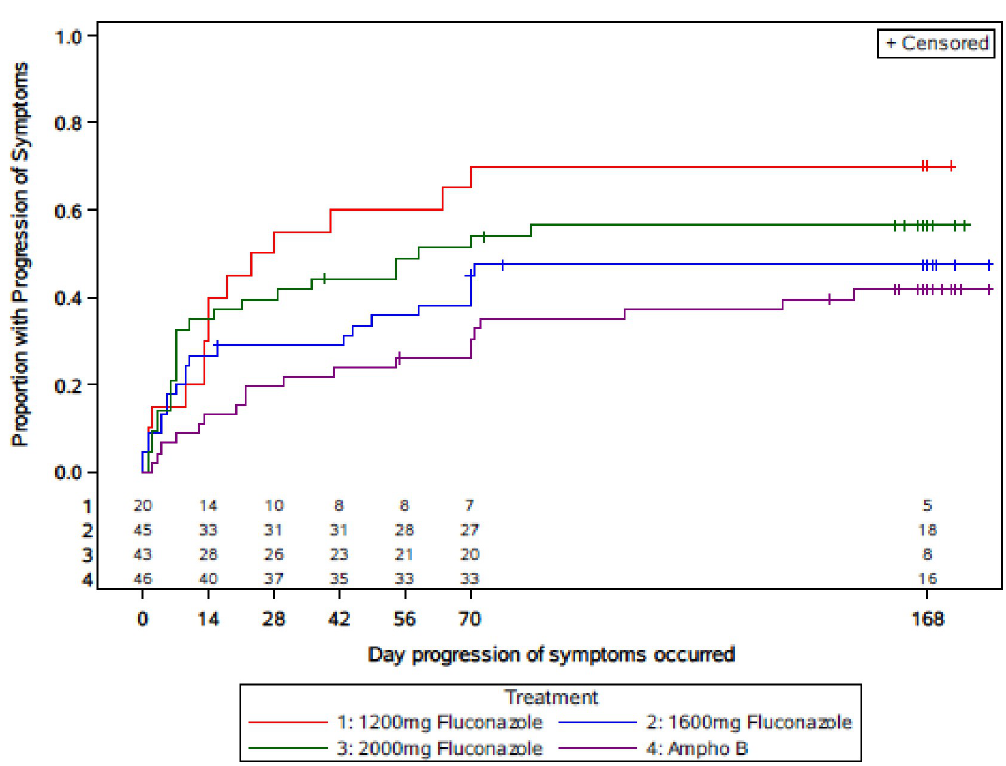
Fig 4. Time to progression of symptoms through end of